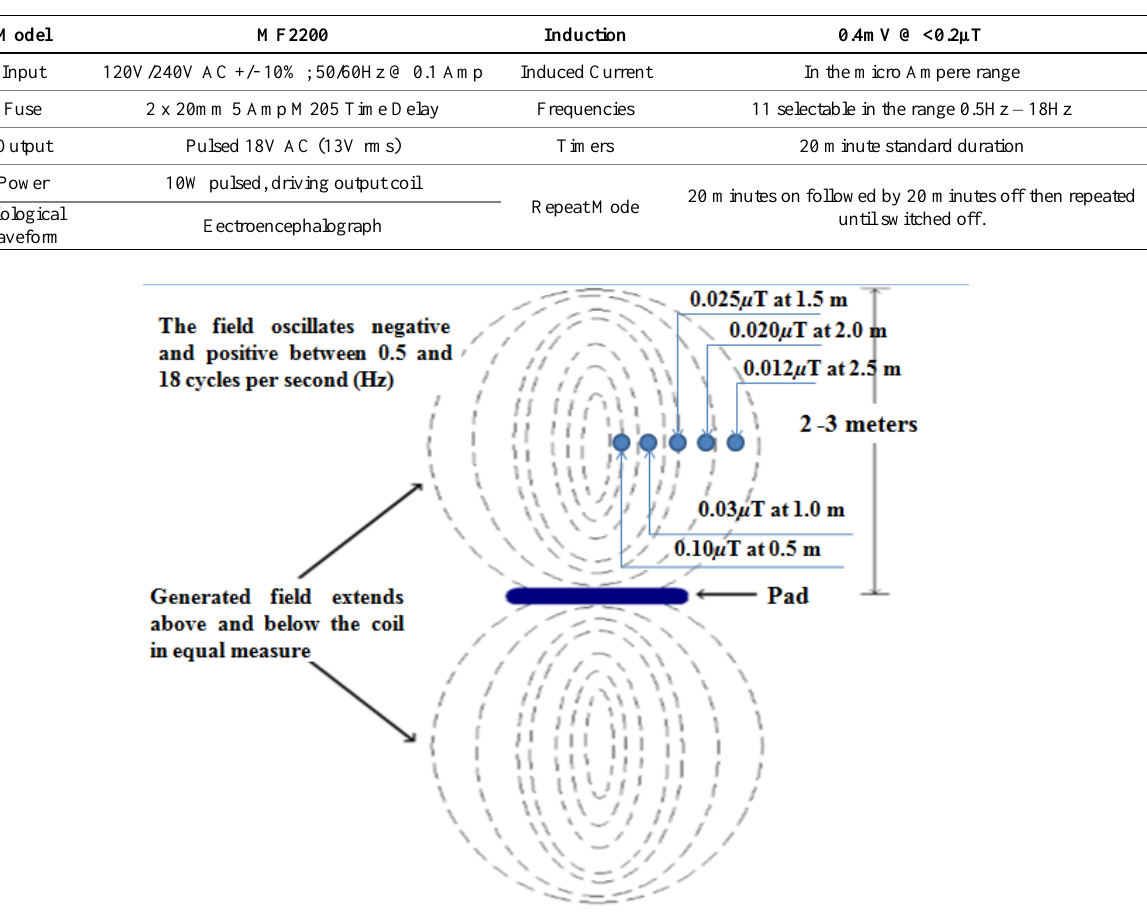
Figure 1. The approximate shape of the predominant enclosed electromagnetic fields when the frequency is at 12Hz.